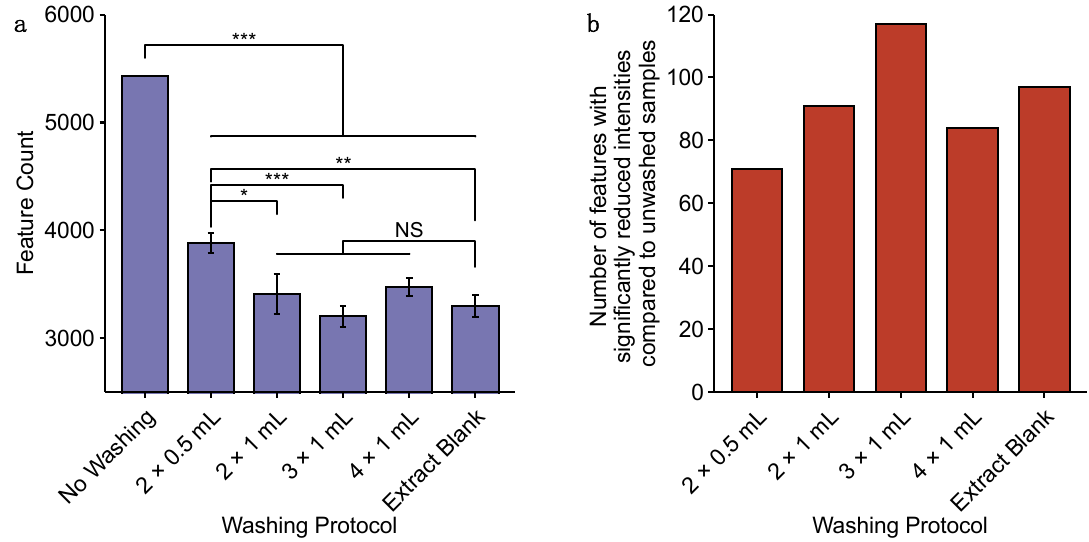
Figure 2. Evaluation of washing procedures for filtration-based sampling of microtissues. ( a ) Bar chart showing the total number of features detected in process blanks prepared without washing, or with 2 × 0.5 mL, 2 × 1 mL, 3 × 1 mL or 4 × 1 mL saline washes, followed by 1 × 1 mL water wash. Negative control data were acquired from extraction blanks (i.e., no medium was passed through the cell strainer prior to extraction). Error bars display standard error across 3 replicates. Significant differences between groups (one-way ANOVA with Tukey’s post hoc test) are displayed: *** p < 0.01, ** p < 0.05, * p < 0.1, NS, not significant. ( b ) Bar chart showing the number of features (of 2023 features detected in ≥ 2 of 3 replicates in each group) whose intensities are significantly reduced by each washing protocol compared to no washing. Significant reduction in feature intensity is defined where fold change of median intensity in washed samples compared to non-washed samples is <1 and q < 0.1, calculated by one-way ANOVA with Tukey’s post hoc test and FDR correction.